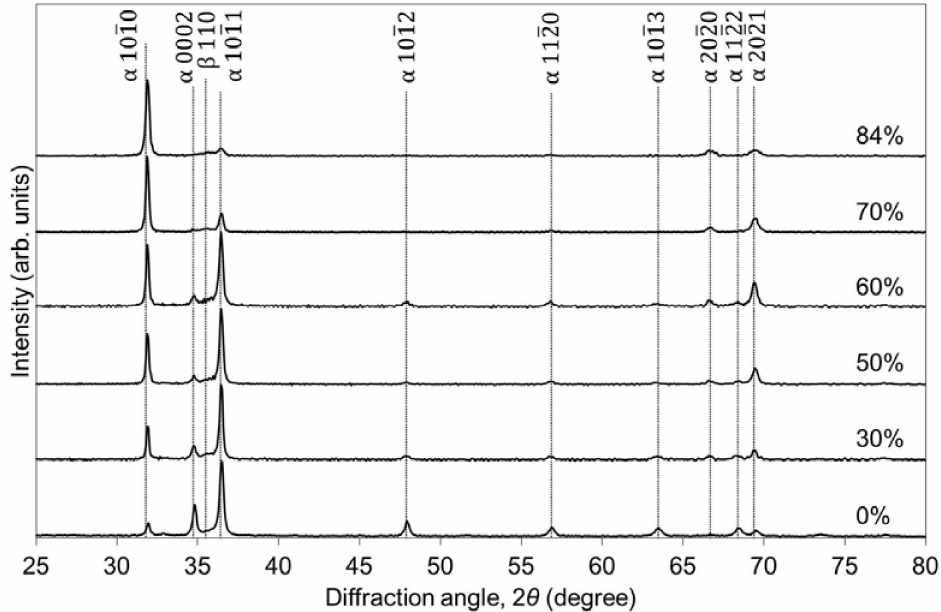
Figure 2. XRD profiles of Zr–1Mo alloy specimens extracted parallel to the processing direction and with area reductions of